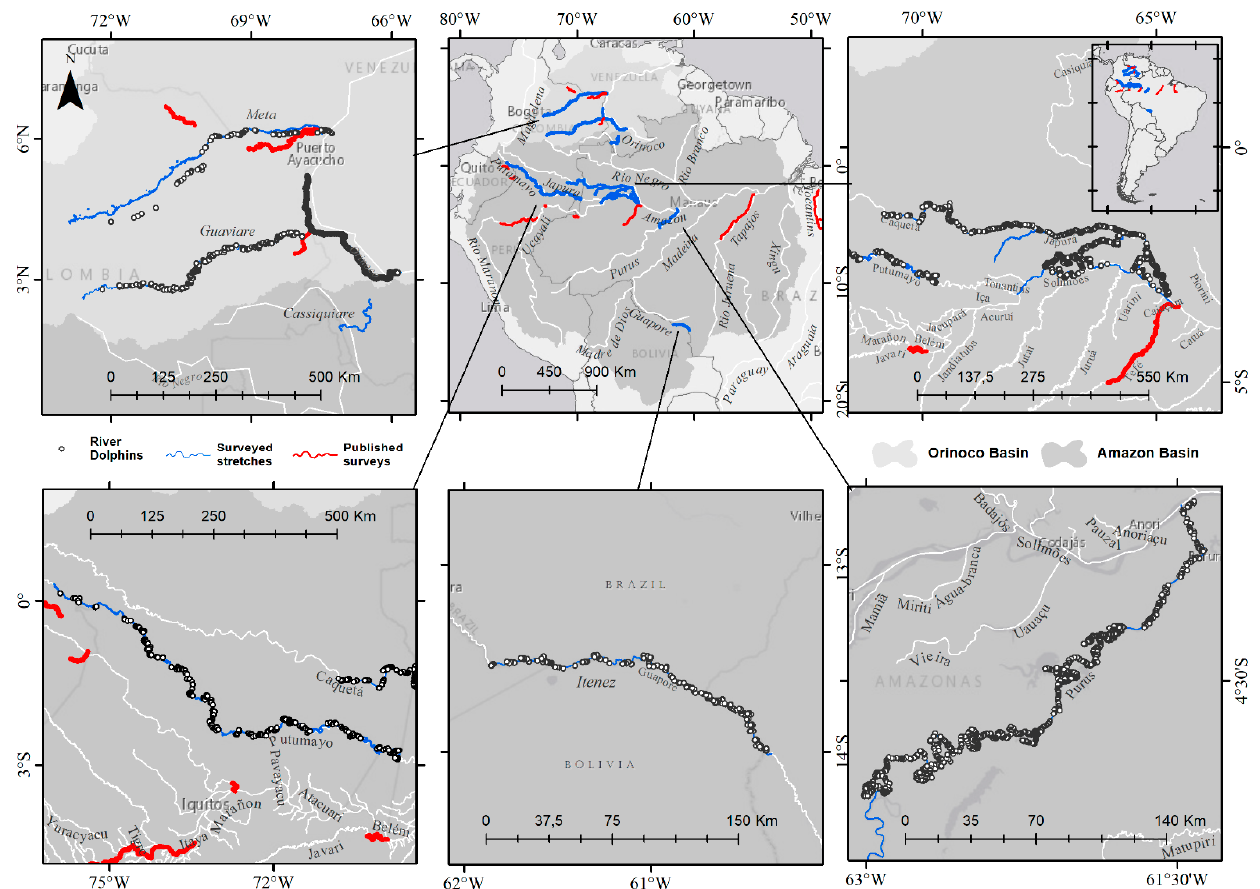
Figure 1. Rivers and stretches of rivers sampled for density and abundance estimates of South American river dolphins (boto and tucuxi) through the lowlands of the Amazon and Orinoco basins. Published studies are in red, and the present data analyzed are in blue. Table 1. Sampling effort and study areas of South American river dolphins (boto and tucuxi) abundance estimates in the Amazon and Orinoco basins, following chronological order of sampling effort from 2012 to 2018.